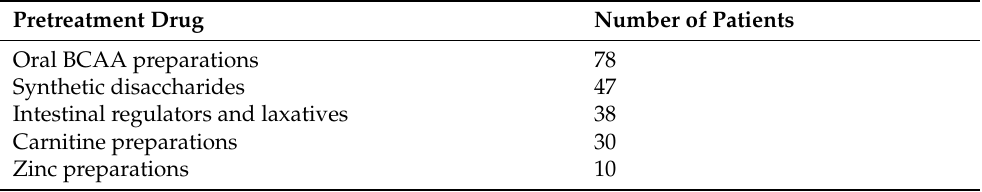
Table 2. Patient pretreatment drug history for hyperammonemia